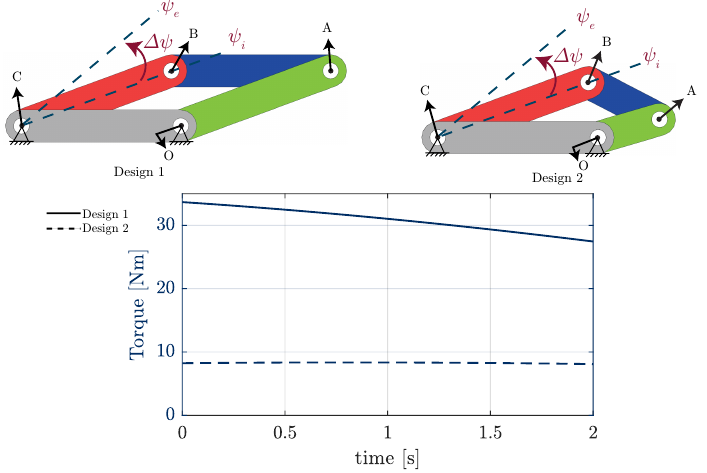
Figure 2. Defining certain lengths for the links of a four-bar mechanism influences the required torque to move the output link BC from ψ i to ψ e driven from Point O/Input Link